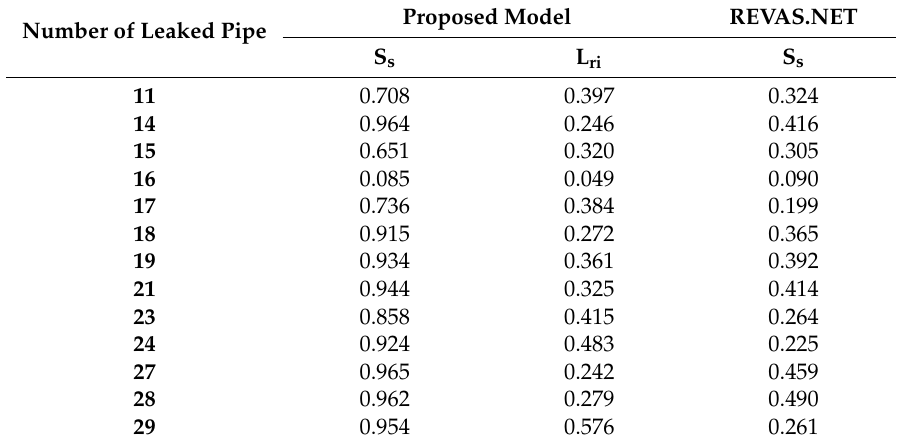
Table 6. The results of the proposed model and REVAS.NET according to the number of leaked pipes. Number of Leaked